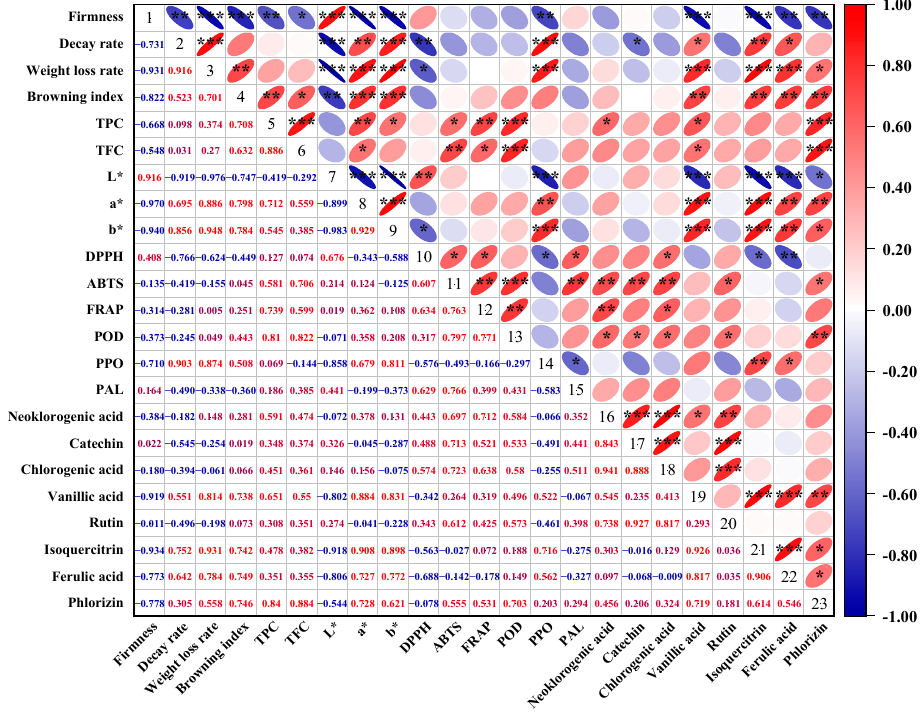
Figure 8. Heat map of correlation analysis of yellow peach index parameters for different treatments,